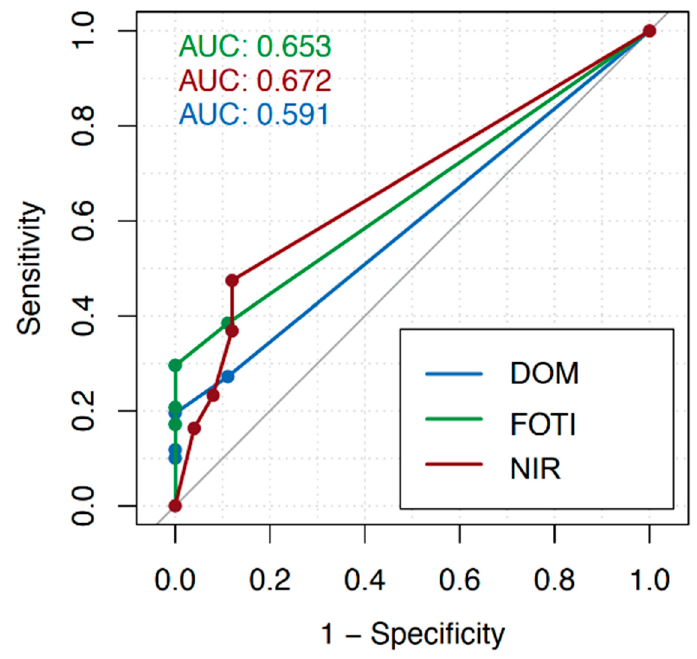
Figure 4. Receiver operating characteristic (ROC) curves considering proximal surfaces only (dental operating microscope, DOM; fiber-optic transillumination, FOTI; near-infrared transillumination, FOTI) and different cutoff values of the crack depth scores. The diagnostic value of each method was calculated as the area under the curve (AUC).